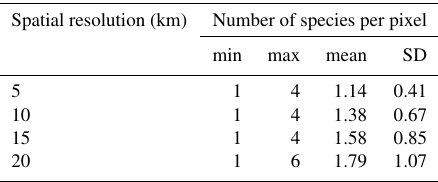
Table A3. Descriptive statistics of the number of species per pixel, by pixel spatial resolution (km): min is minimum, max is maximum, mean is average, and SD is standard